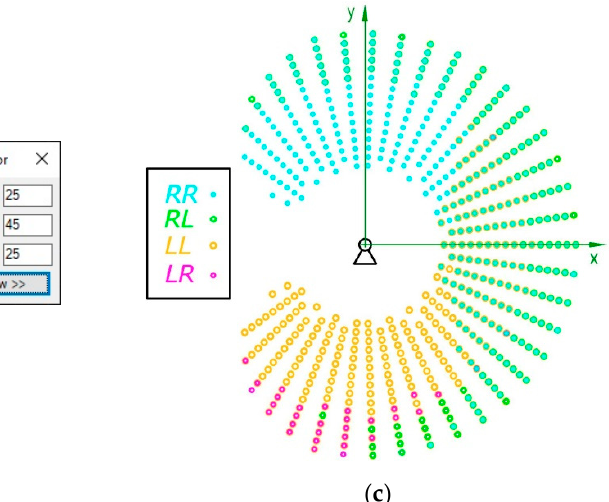
Figure 15. ( a ) Dialog window for setting the basic geometrical parameters of the robot. ( b ) Dialog window for generating points in polar coordinates. ( c ) Generated workspace divided by type of available solutions.